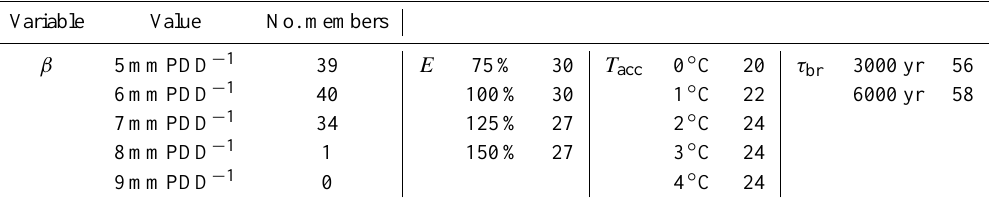
Figure 6. The dependence of the minimum sea level with respect to the different model parameters (rows) and climate forcing (green=LGM uc , blue=LGM bs ). The light colored boxes contain 95% of the simulations; the darker box contains half of the total. The median is drawn as a line, and the average as a black dot. The two columns of dots in one ensemble of panel (a) show the different values of τ br . The columns of dots in panels (b–d) represent the five values of β from the first panel. Table 4. Distribution of ensemble members that simulate a LGM sea level anomaly consistent with reconstructions (see horizontal gray bar in Fig. 7, total 114 members). Mean values for all members listed below: β = 5.97mmPDD − 1 , E = 111%, T acc = 2.09 ◦ C, τ br = 4526